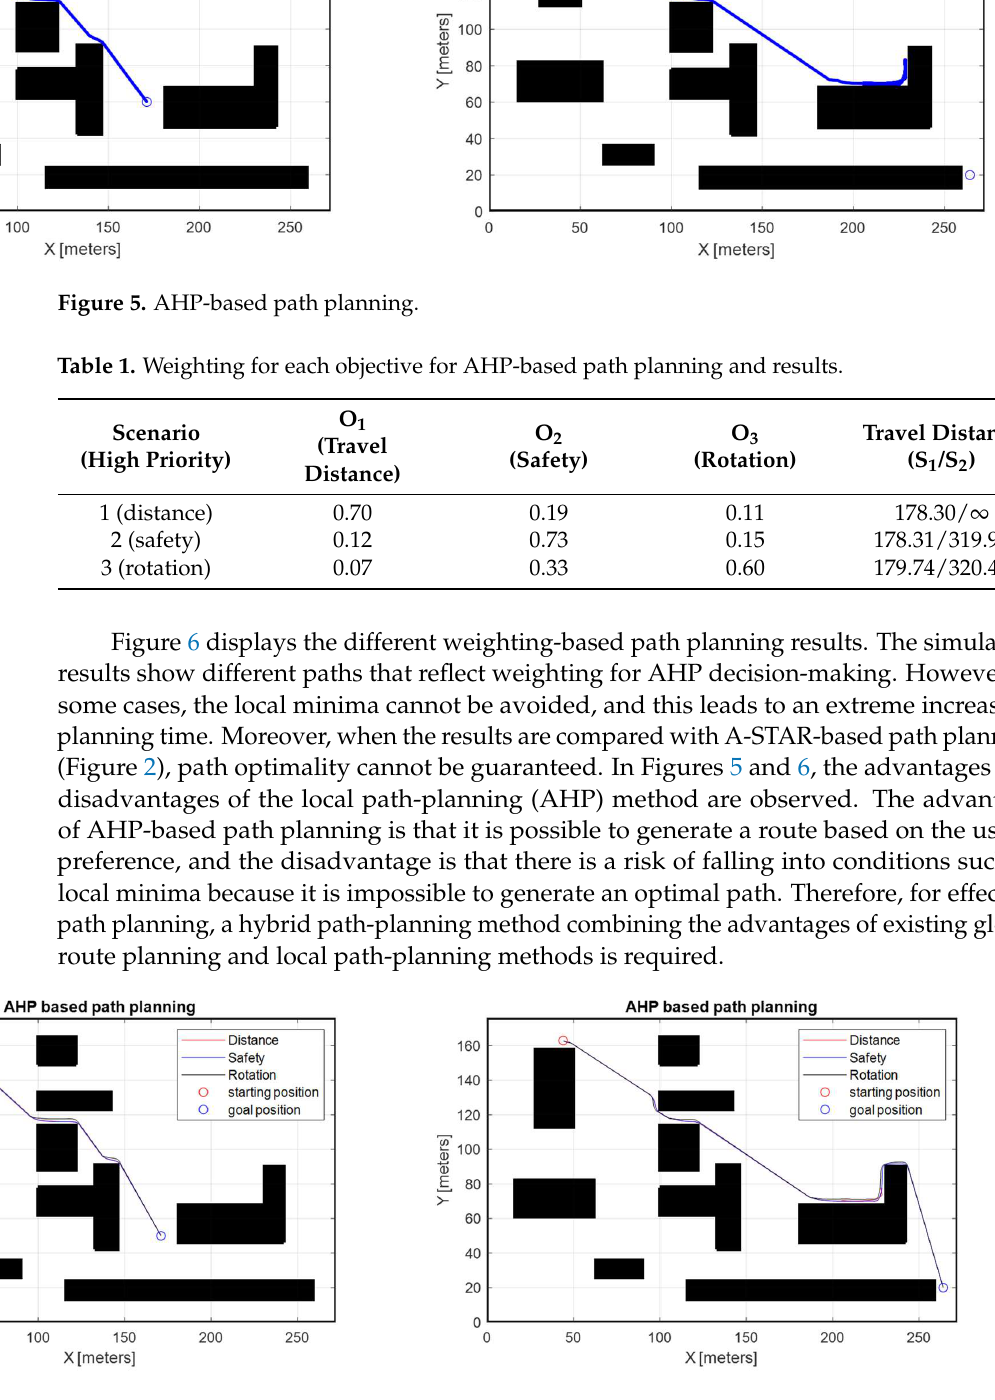
Figure 6. AHP-based path planning.